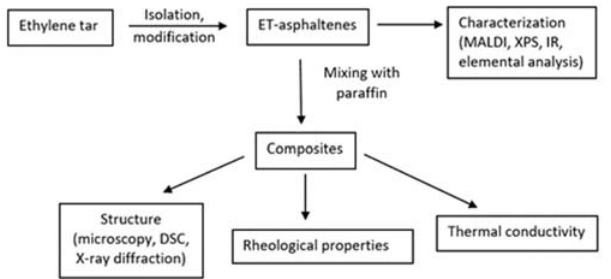
Figure 10. Research methodology flow chart.